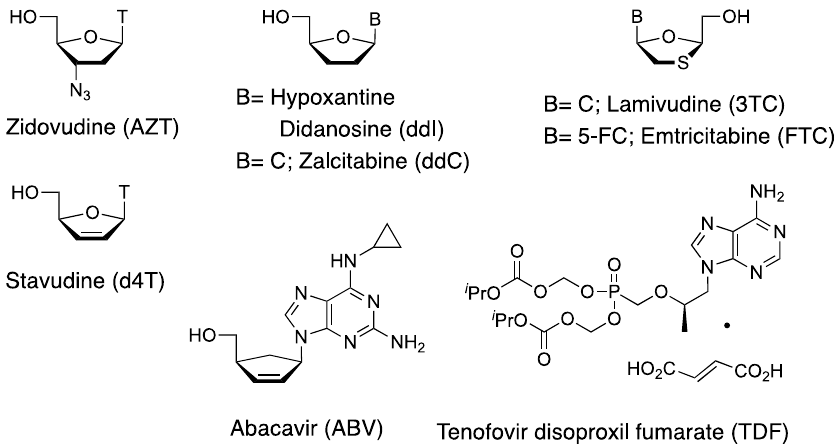
Figure 1. Several approved NRTIs against HIV.